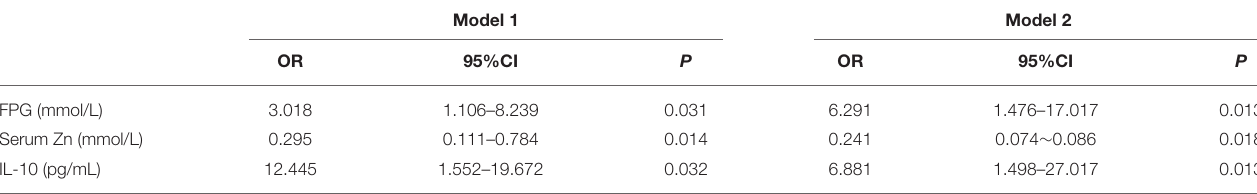
TABLE 2 | Predictors of DN identified by logistic regression analysis, adjusted for a history of hypertension.